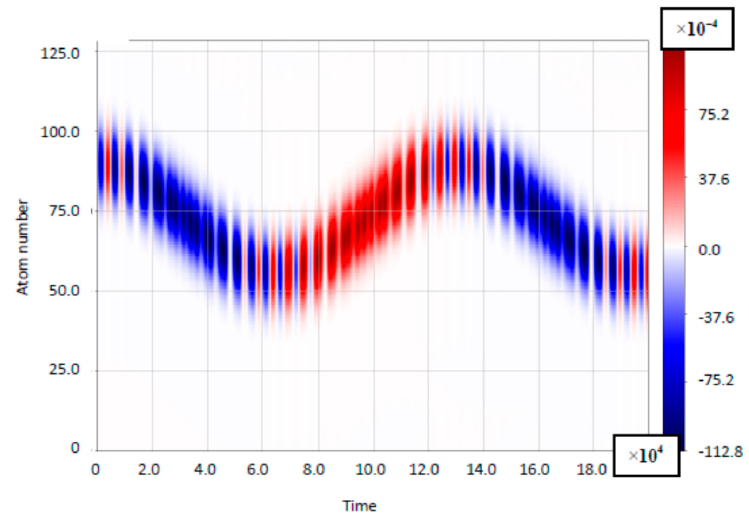
Figure 4. Space-time distribution of the tunnel current density with RO and BO in the separated frequency ranges. t a = t b = 0.04. All other parameters are identical to Figure 3.